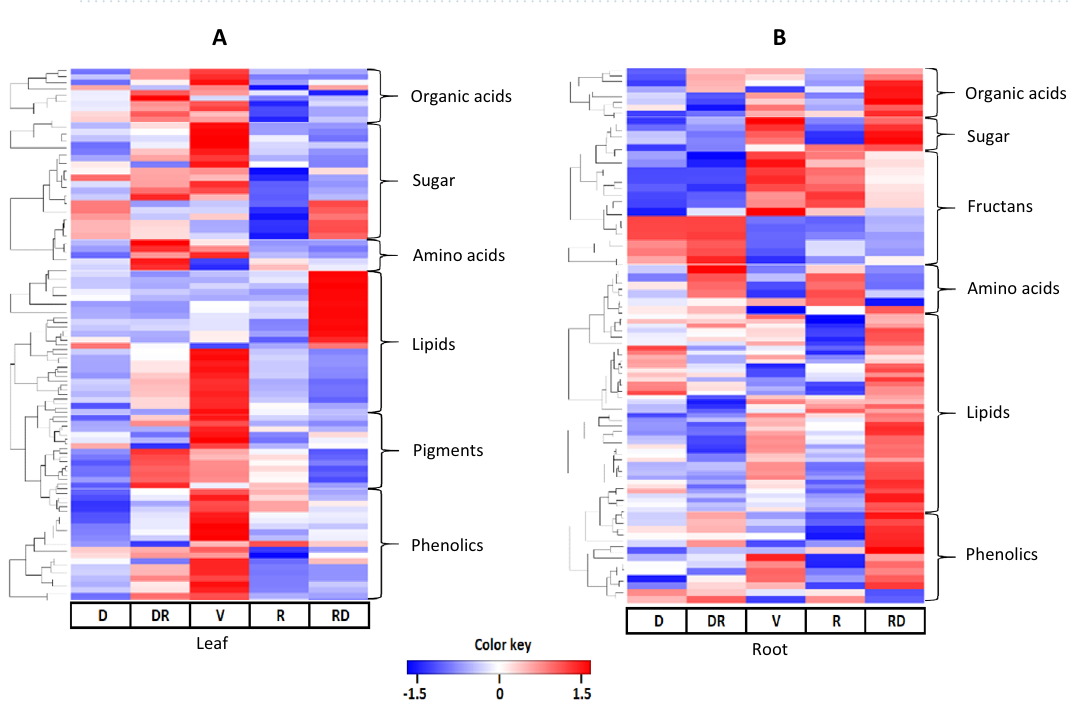
Figure 6. Heatmap visualization from a cluster hierarchical analysis of annotated metabolites of leaf and root of Gomphrena agrestis Mart. in a rock-field area in the dry and rainy seasons. D dry period, RD transition from dry to rainy period, V veranico period, R rainy period, RD transition from rainy to dry period. Performed using R-software version 3.4.1 66